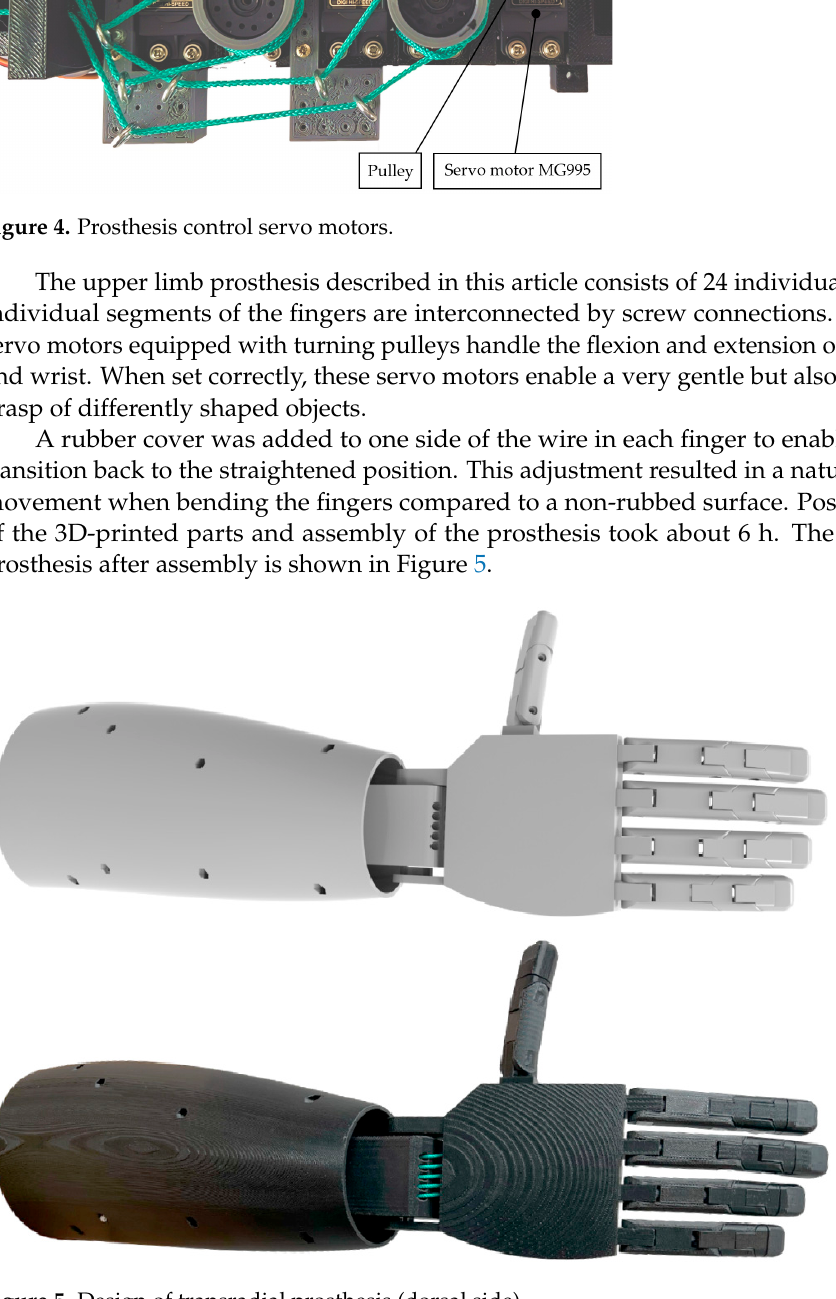
Figure 5. Design of transradial prosthesis (dorsal side).